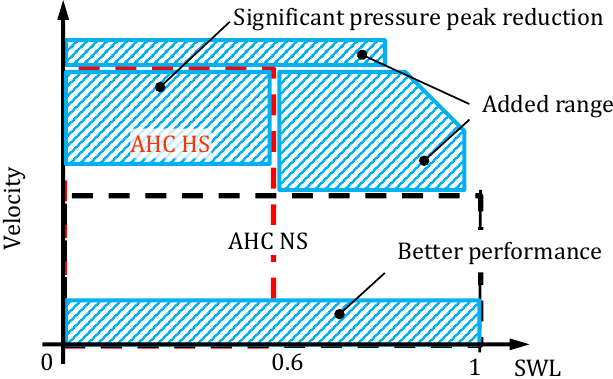
Figure 27. Significant findings from comparison between the classic controller and the